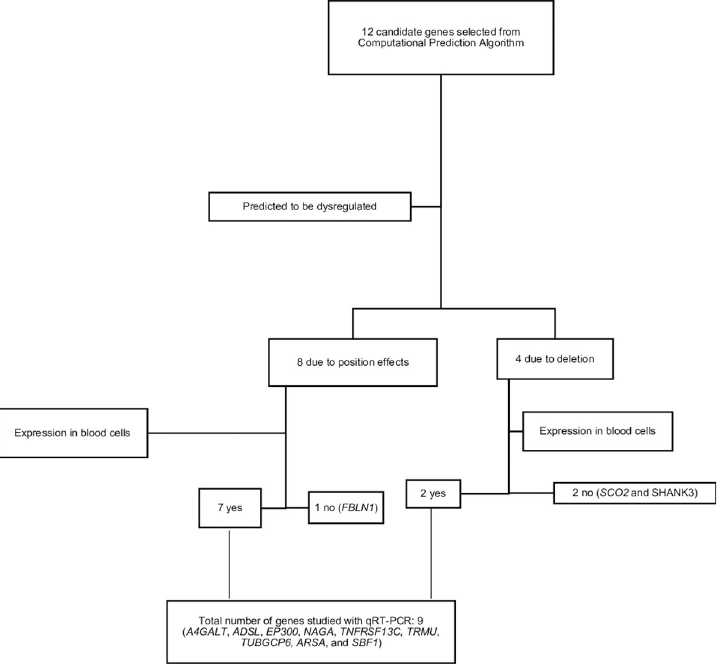
Fig 2. Flowchart for selection of genes for qRT-PCR analysis. Twelve candidate genes were identified with 9 genes being expressed in blood and able to be assessed with qRT-PCR. Seven of the 9 were predicted to be dysregulated due to position effects and 2 were predicted to be dysregulated due to